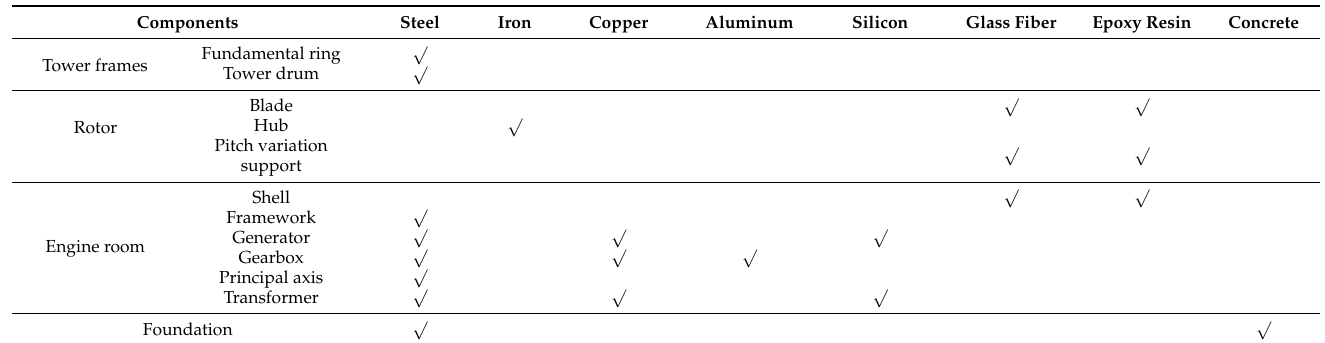
Table 2. The elementary raw materials in the wind